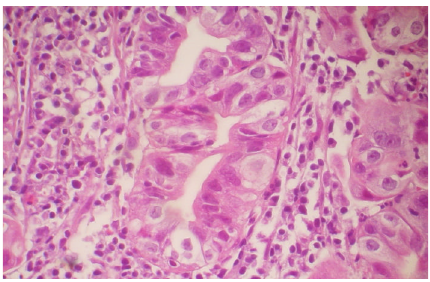
Figure 2: Microscopic scheme of nonmetastatic intestinal type gastric